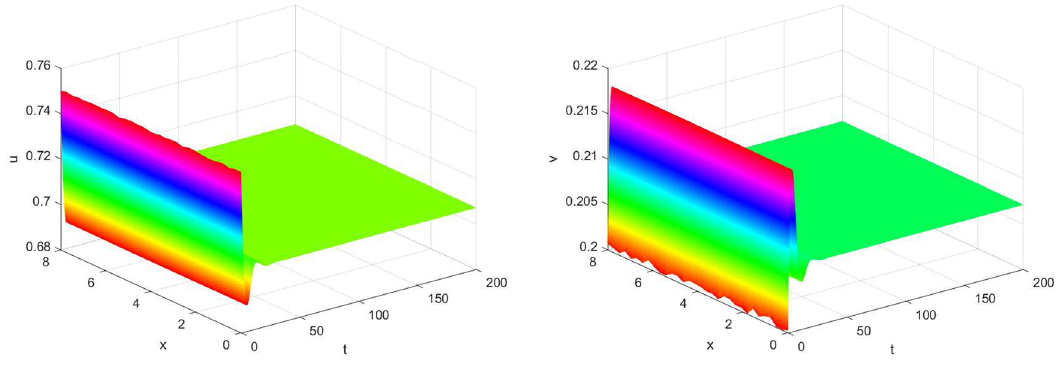
Figure 3: Phase portraits of ( 1.5 ) with parameters =